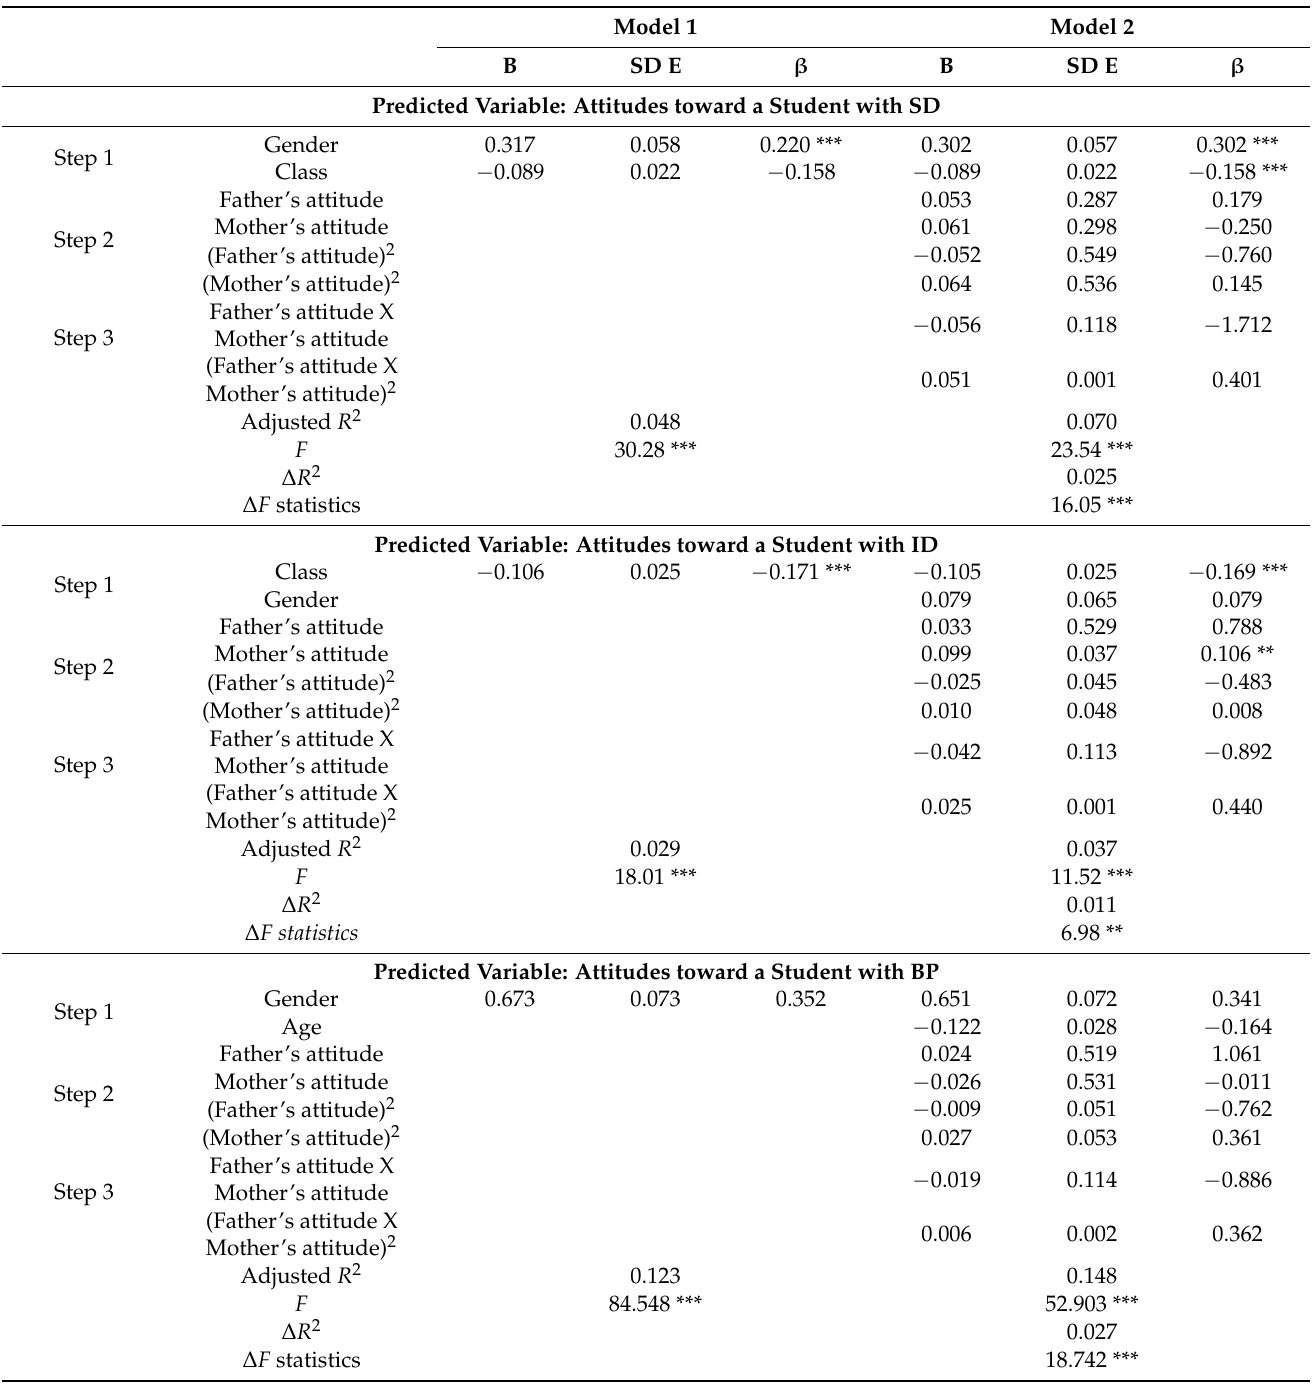
Table 2. Results of Hierarchical Regression Analyses showing the amount of variance in a child’s attitudes toward students with disabilities accounted for by the simple and combined effects of parents’ attitudes. Model 1 Model 2